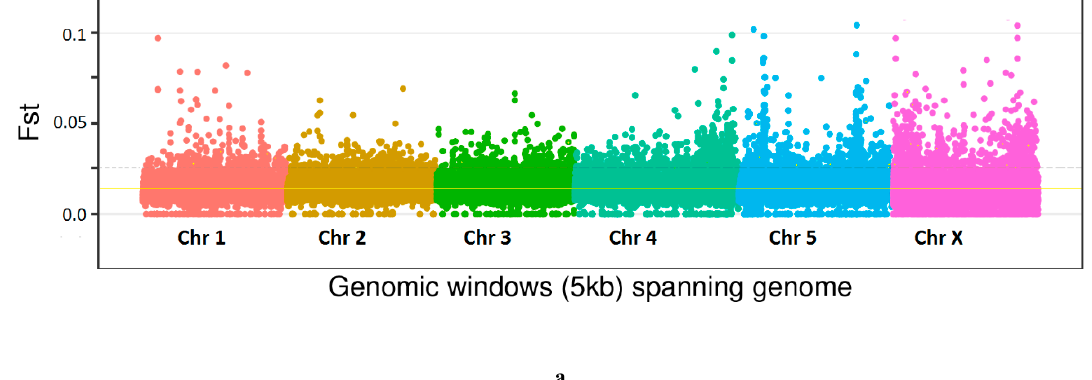
Table S4. Chromosome-wise distribution of the candidate genes included: 4 on chromosome 1, 1 on chromosome 2, 2 on chromosome 3, 2 on chromosome 4, 7 on chromosome 5, and 10 on chromosome X. The candidate genes were related to chloride channels including glutamate-gated chloride channel, oxidation-reduction process (cyt-p450), GPCR, ABC transporter and pgp, NHR (nuclear hormone receptors), Lgc (ligand-gated channel), vesicle-mediated transport, and transmembrane transportation of ions.